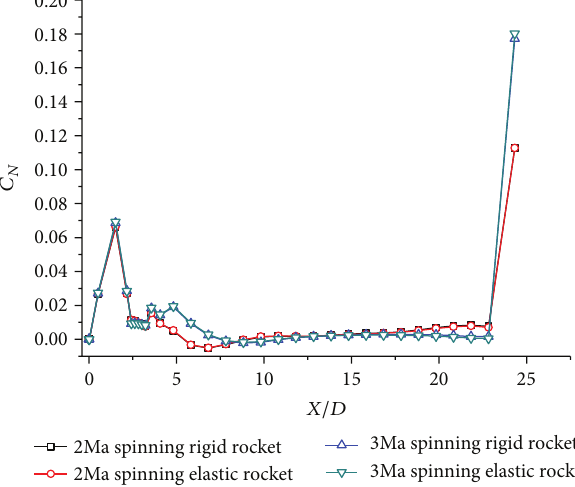
Figure 10: Spinning rocket distributed normal force coefficient along rocket length at Ma = 2,3 and 𝛼 = 4 ∘